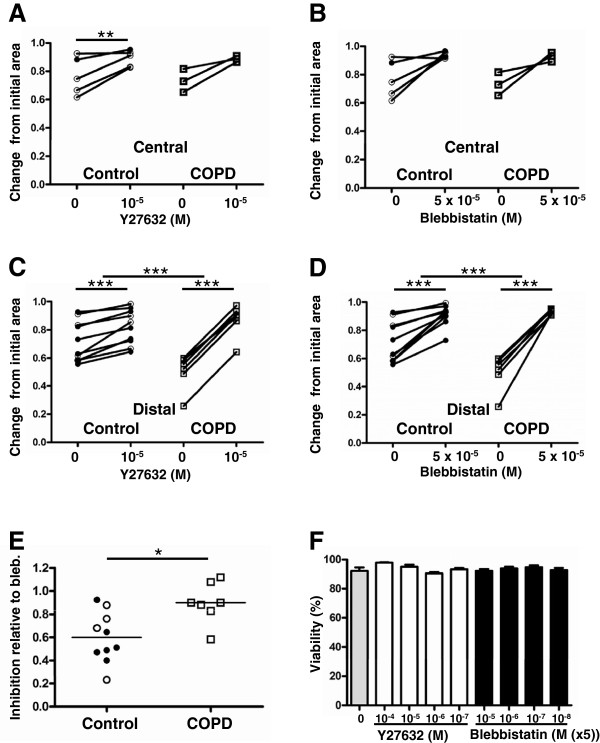
The effect of ROCK on fibroblast contraction. The influence of ROCK1 on the contractile potential of isolated fibroblasts was investigated using collagen contraction gels. Cells were pre-treated with different concentration of the ROCK inhibitor Y27632 or the myosin II inhibitor blebbistatin for 1 hour and contraction was monitored as the gel areas after 24 hours compared to the initial gel areas. Paired comparison of centrally derived fibroblasts (A) or distally derived fibroblasts (C) from control subjects and COPD patients with and without Y27632 after 24 hours incubation. (B) paired comparison of centrally derived fibroblasts or distally derived fibroblasts (D) from control subjects and COPD patients with and without the myosin II inhibitor:blebbistatin after 24 hours incubation. (E) Comparison of the inhibitory effects of Y27632 and blebbistatin calculated as (Y27632-untreated) / (blebbistatin-untreated) after 24 hours incubation for distally derived fibroblasts. (F) Cytotoxicity of the used antagonists shown as viability as determined by trypan blue exclusion after 24 hours exposure. Open symbols represents fibroblasts isolated from lung explants and closed symbols fibroblasts isolated from lung biopsies. *P < 0.05, **P < 0.01, *** < 0.001.